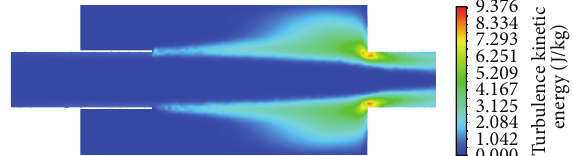
Figure 6: Counters of turbulent kinetic energy for the expansion chamber silencer with inlet flow velocity of V = 10.2